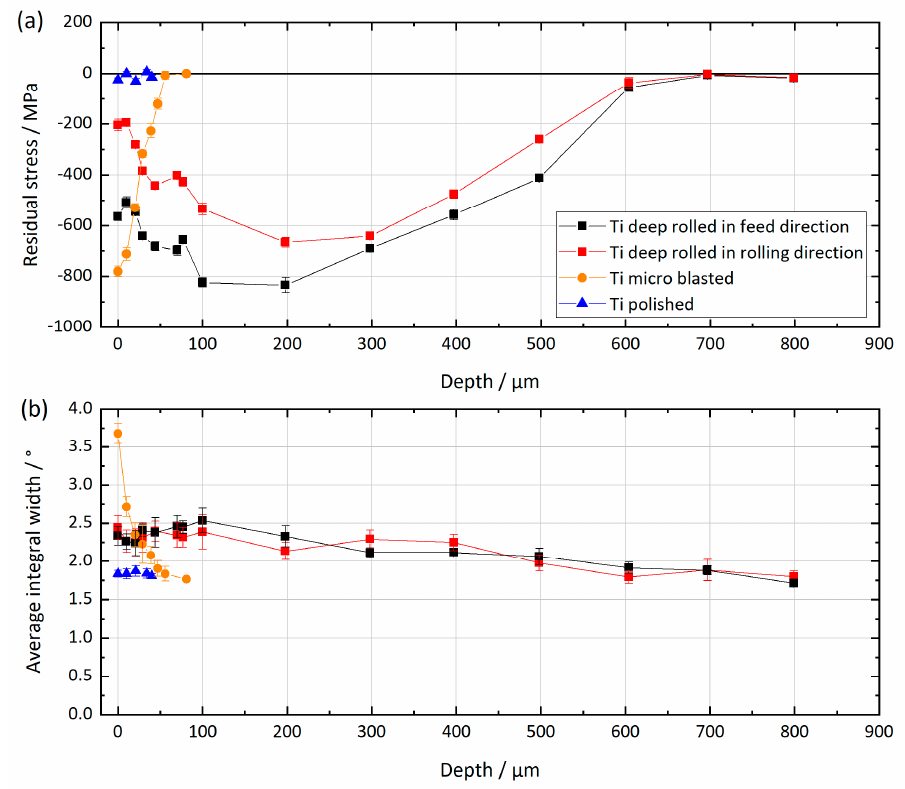
Figure 3. Residual stress depth distributions (a) and depth distributions of the average integral widths of the diffraction lines (b) for the three differently mechanically surface-treated Ti6Al4V (Ti) samples.